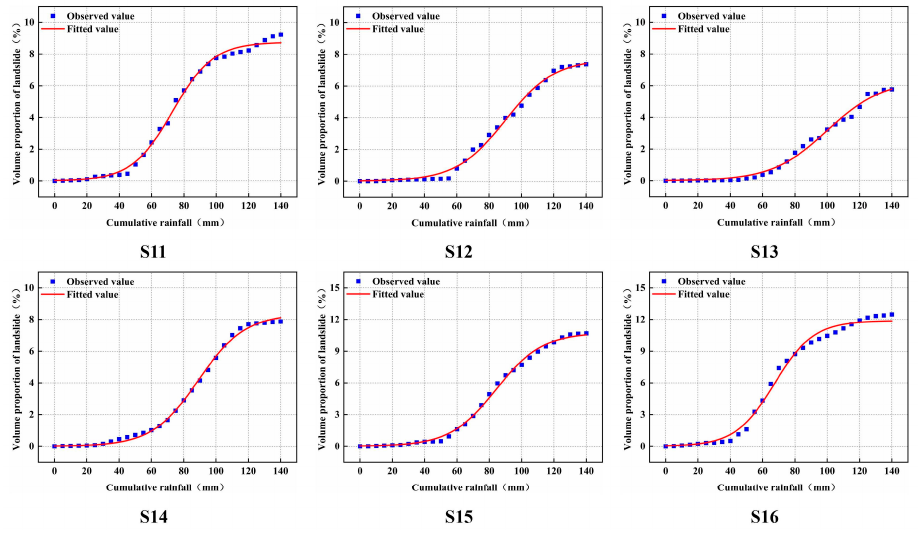
Figure 5. S-growth curve fitting (S11–S16). Table 3. Fitting parameters.